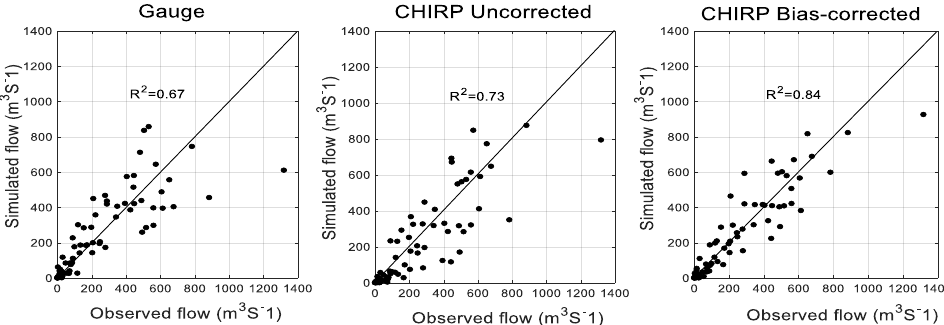
Figure 8. Monthly scatter plots of the observed flow against the simulated flow using gauge-based, uncorrected, and bias-corrected CHIRP rainfall data at Meki catchment from 1986–1991.